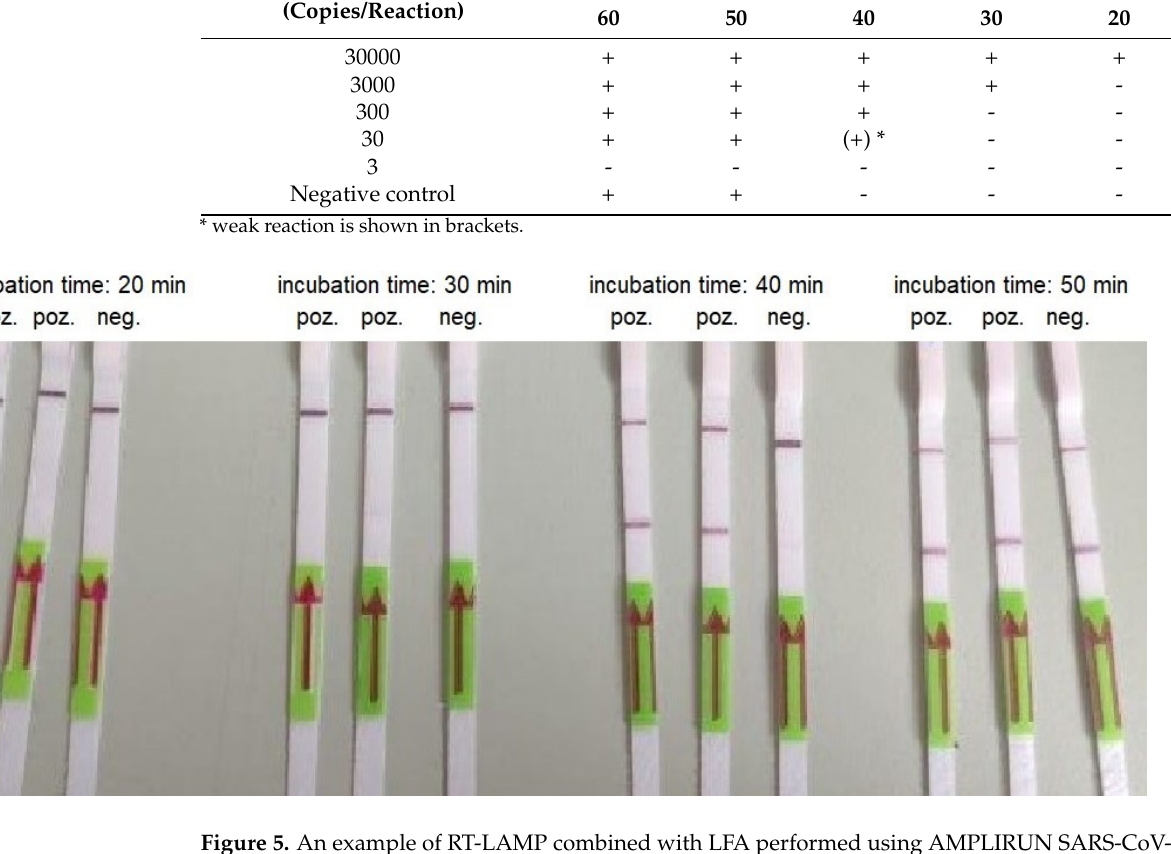
Figure 5. An example of RT-LAMP combined with LFA performed using AMPLIRUN SARS-CoV-2 RNA control at concentration 300 copies/reactions and various incubation times.